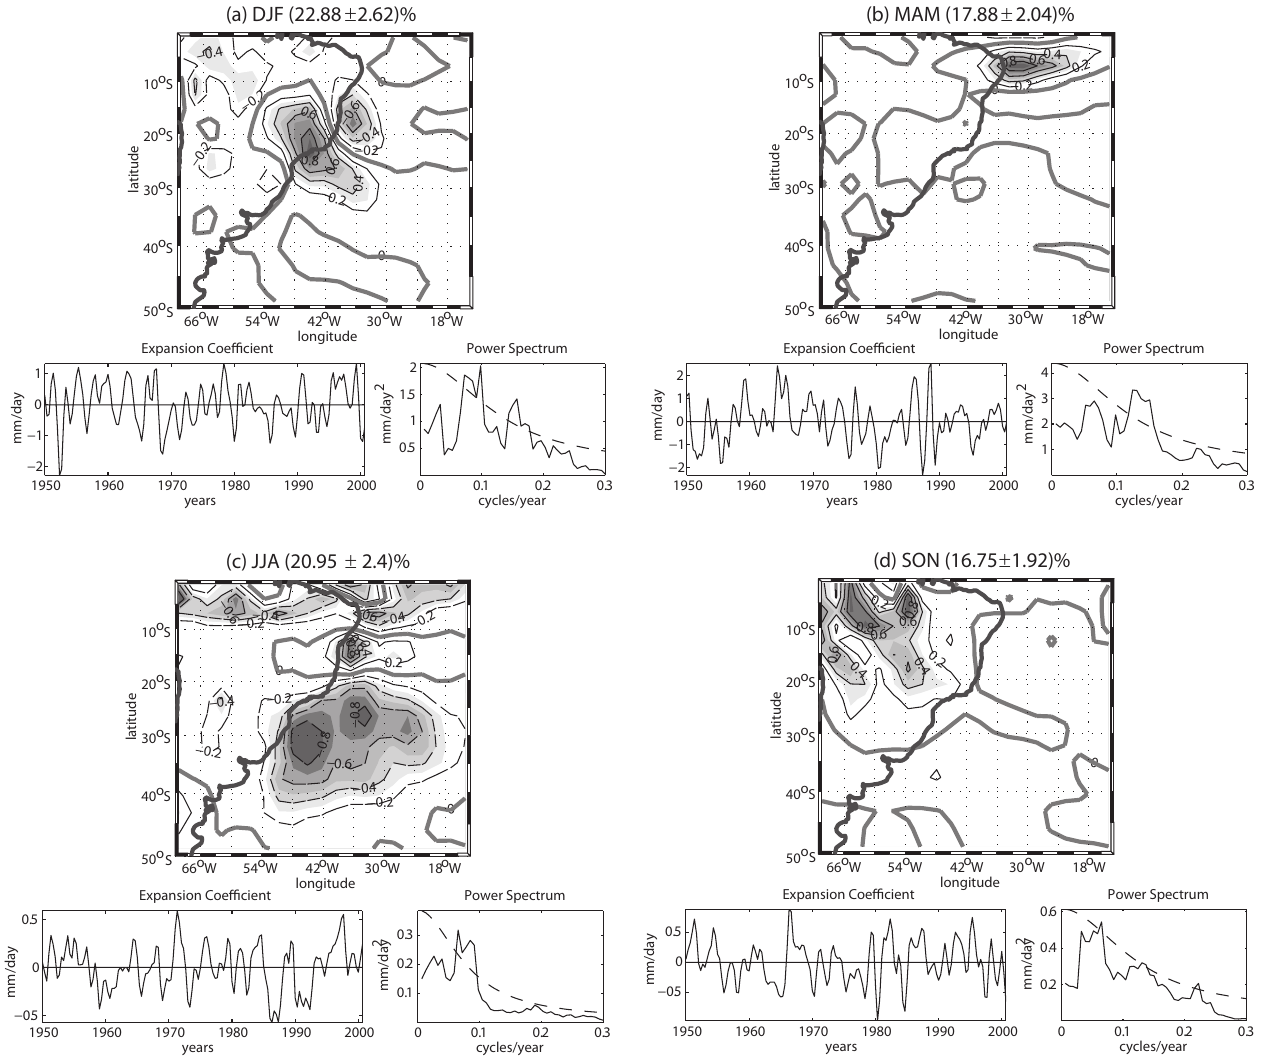
Fig. 10. Second mode of REOF for simulated precipitation from EXP2 without the ENSO signal. Shaded areas represent eigenvector magnitudes higher than | 0.3 | . Time series of expansion coefficients (mmday − 1 ) and the associated power spectrum are located in the panel below. The power spectrum is calculated via multitaper method. Frequencies above the dashed line are significant at the 95% level relative to a red noise background spectrum. (a) DJF, (b) MAM, (c) JJA and (d)